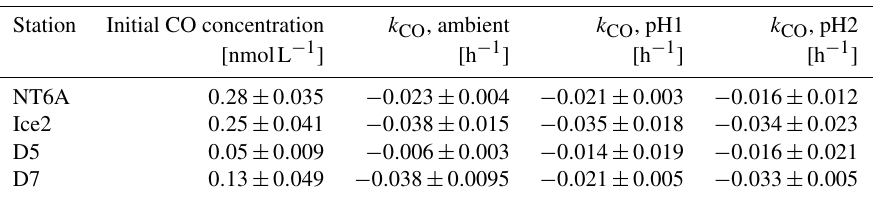
Table 1. Initial CO concentrations and CO consumption rate constants ( k CO ) of the four incubation experiments conducted at different pH levels. Data are given as the mean ± the estimate of the standard deviation (for the initial CO concentrations) and as the slope of the linear regression ± the error in the slope (for k co ).